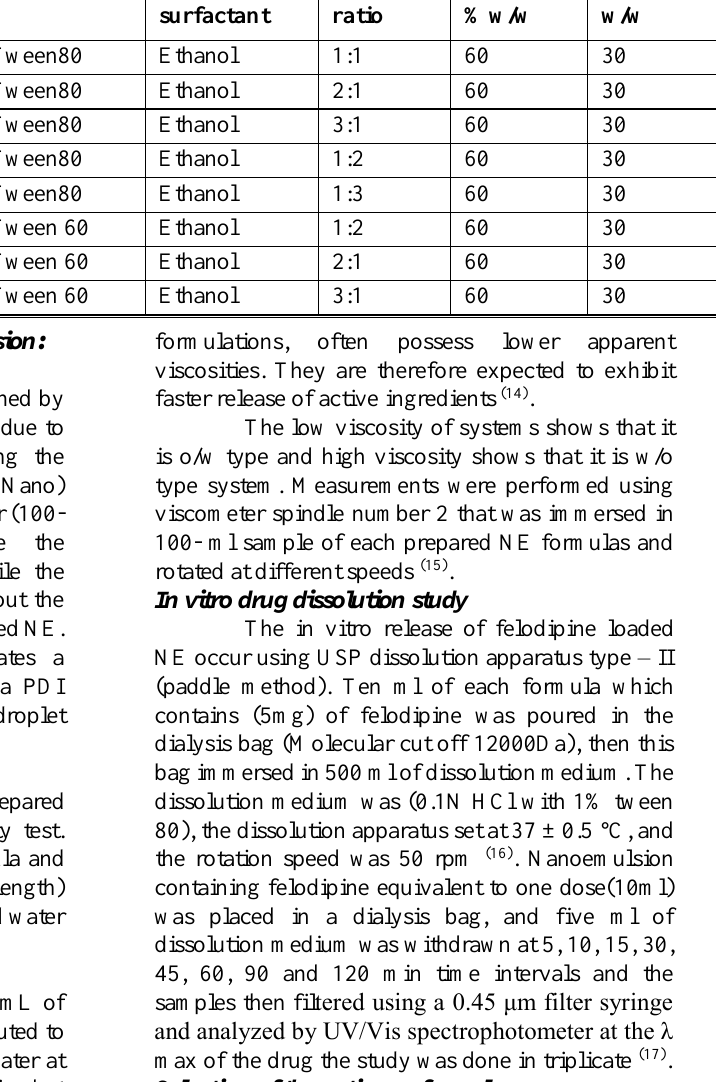
Table 2. Composition of different felodipine nanoemulsion